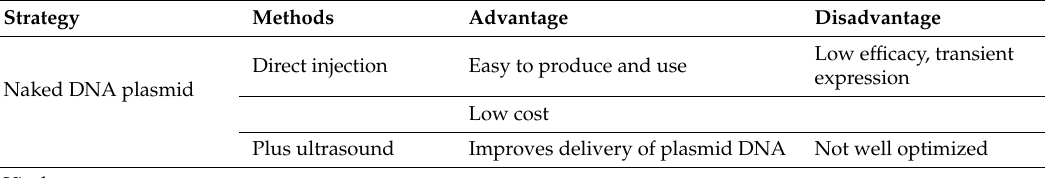
Table 2. Gene delivery